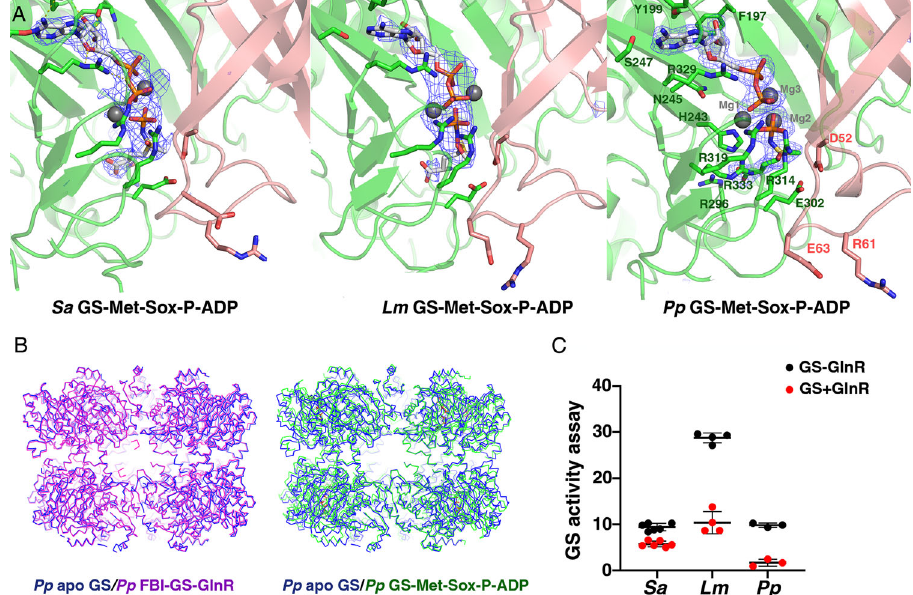
Fig. 5 Structures of GS Met-Sox-P-ADP transition state complexes. A Omit electron density maps were calculated after removal of the Met-Sox-ADP and contoured at 3.8 σ for the Sa GS-Met-Sox-P-ADP complex, the Lm GS-Met-Sox-P-ADP complex, and the Pp GS-Met-Sox-P-ADP complex. Electron density is shown as blue mesh, GS subunits are colored green and salmon and the bound Met-Sox-P and ADP are shown as sticks. Contacts are shown and contacting residues are labeled for the high-resolution Pp GS-Met-Sox-P-ADP complex (the other structures show the same interactions). Interacting residues are shown as sticks and magnesium ions are shown as gray spheres. B C α superimpositions of the Pp apo GS dodecamer (blue) onto the Pp FBI- GS-GlnR dodecamer (magenta) and of the Pp apo GS dodecamer (blue) onto the Pp GS-Met-Sox-P-ADP structure (green) underscoring that the apo and GlnR bound structures are similar whereas the GS-Met-Sox-P-ADP shows large differences not only at the level of subunits but overall oligomer conformation. C GS enzymatic assay testing the effect of excess GlnR on GS activity. For these assays, the Sa, Lm , and Pp GS and Sa, Lm , and Pp GlnR full- length proteins were utilized. GS activity was measured (as described in methods) in the presence and absence of GlnR. The results are the average of multiple measurements (from three to six) with the error bar representing SD. Two-way ANOVA using the software GraphPad Prism 9 was performed. The P value for all the source of variation (interaction, row factor, and column factor — as speci fi ed in the software) are statistically signi fi cant (<0.0001) in all three cases ( Lm, Sa , and Bs ). Source data are provided in the Source Data fi